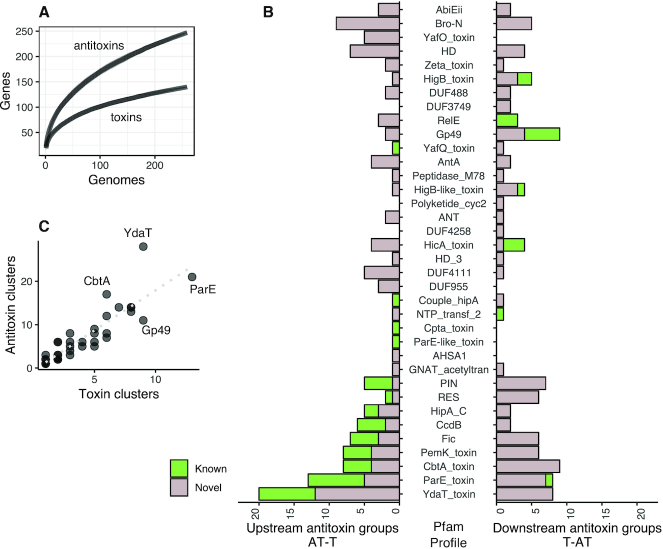
Identification of novel antitoxins in the Klebsiella pneumoniae genomes. (A) Accumulation curves of unique toxins and antitoxins groups found in an increasing collection of K. pneumoniae genomes. (B) Count of antitoxin groups found only upstream (AT-T) and downstream (T-AT) relative to each toxin Pfam profile, coloured by known or novel. (C) Number of toxin groups of each toxin Pfam profile, relative to the number of antitoxin groups found in their proximity.